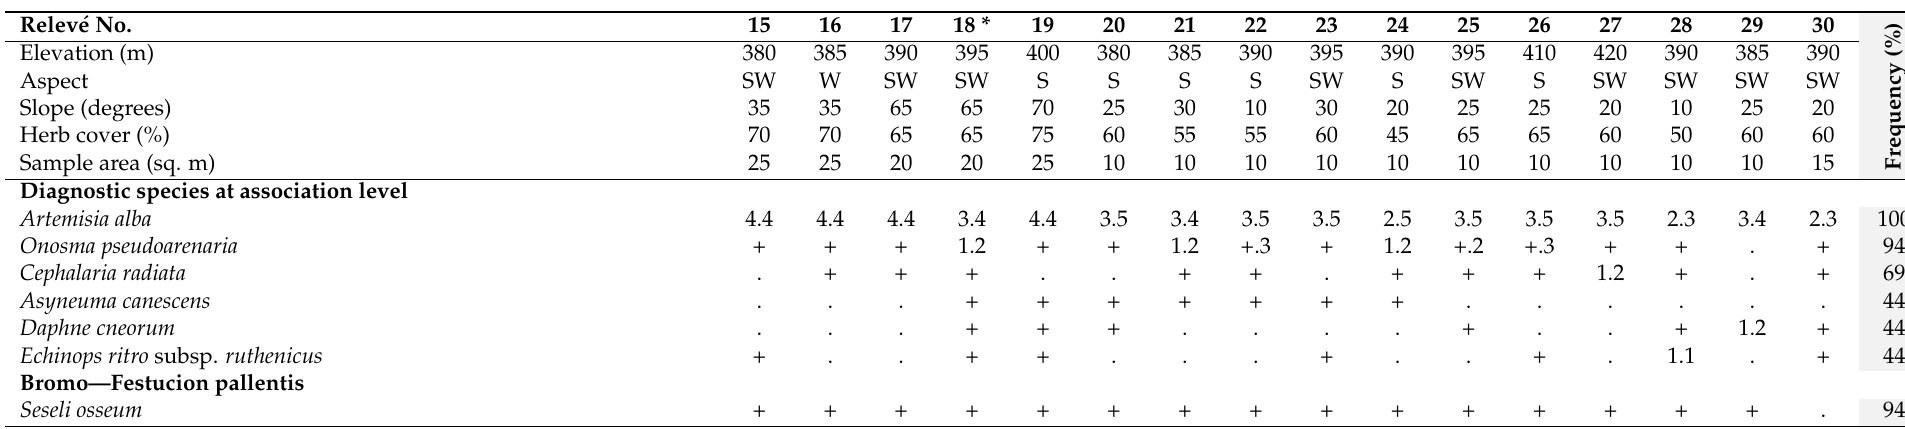
Table 3. Onosmo pseudoarenariae—Artemisietum albae ass. nova hoc loco (* holotypus). Relev é